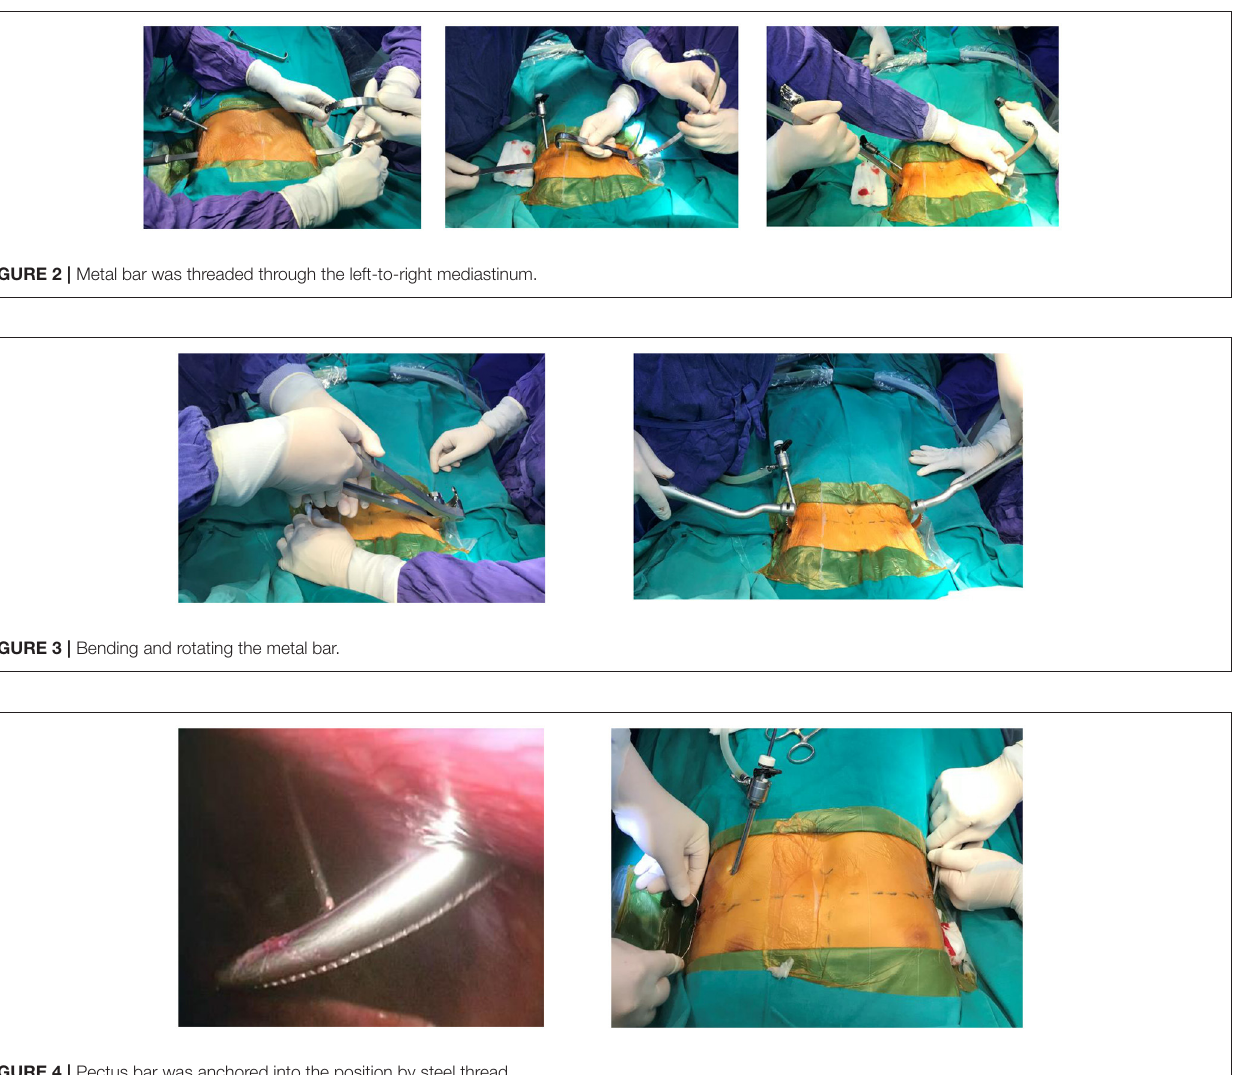
FIGURE 4 | Pectus bar was anchored into the position by steel